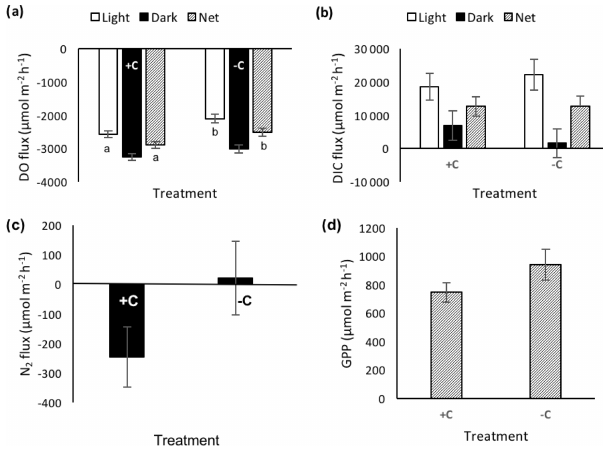
Figure 2. Mean ( ± standard error) benthic light, dark and net fluxes (in µmolm − 2 h − 1 ; n = 5) of (a) phosphate (PO 3 − ), (b) ammonium 4 ) , (c) nitrite (NO − ) , and (d) nitrate and nitrite (NO x ) in incu- (NH + 4 2 bation chambers containing sea cucumbers and aquaculture waste with ( + C) or without ( − C) carbon addition, incubated under light and dark conditions between day 1 and day